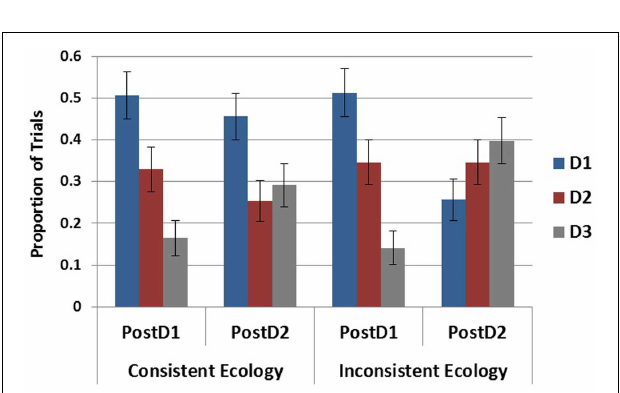
FIGURE 8 | Proportion of generation for each disease within the SbS condition following S1 and S2. Error bars represent standard errors of the mean.